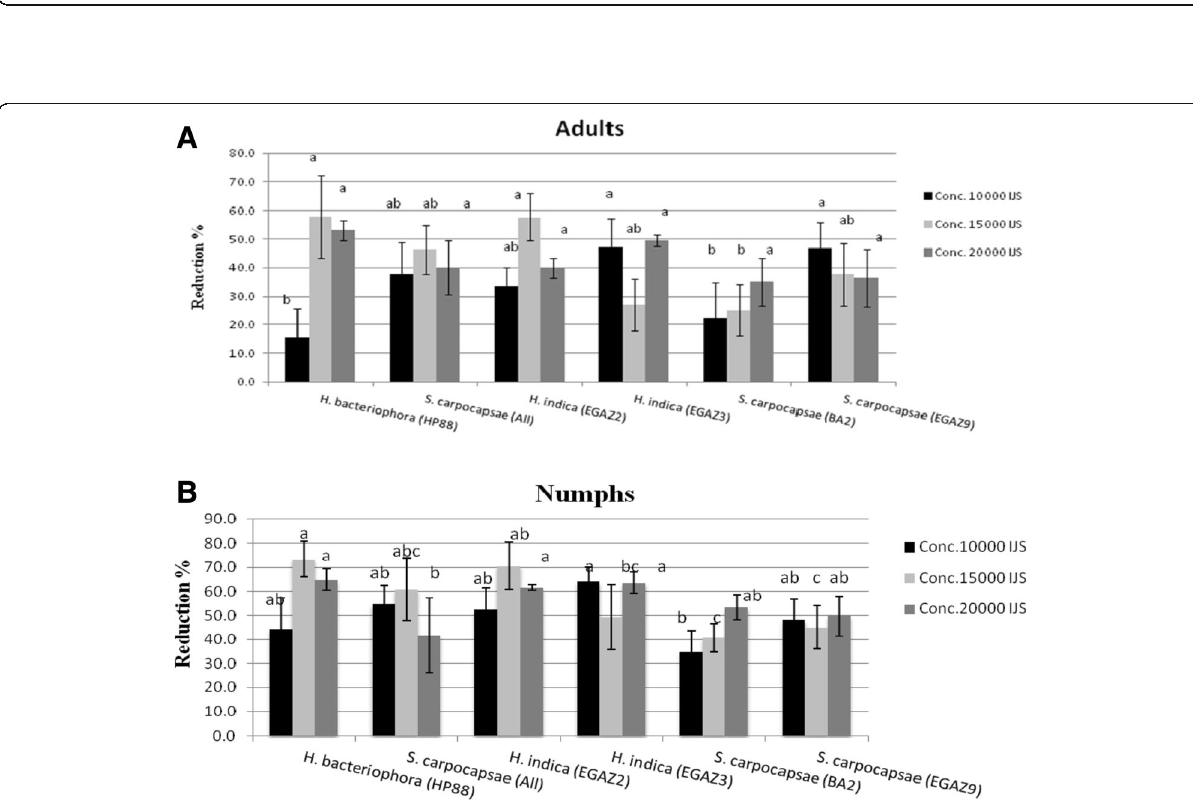
Fig. 2 Reduction percentage for different treated stages using the EPNs after 48 h at different concentrations: a for T. tabaci adults, b for T. tabaci nymphs. Columns annotated with the same letter are not significantly different ( P <